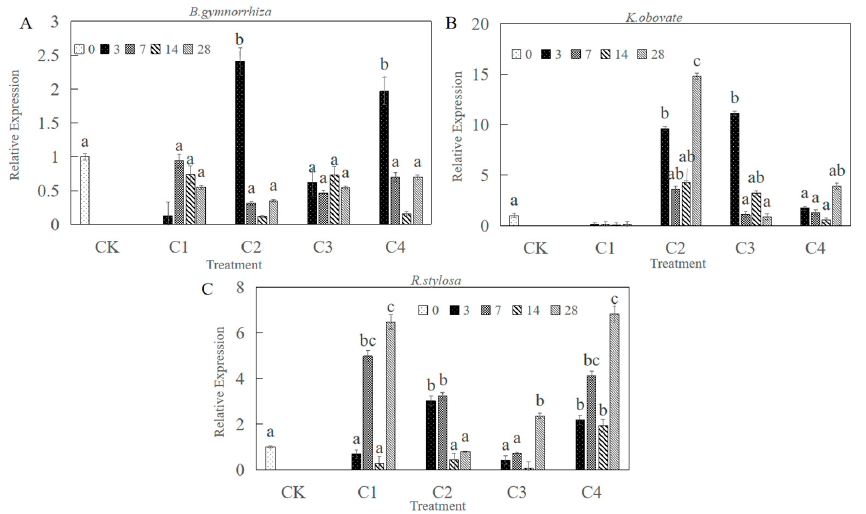
Figure 8. Expression of CHI gene in leaves of three species in response to heavy metal stresses using real-time quantitative PCR analysis. ( A ) Bruguiera gymnorrhiza. ( B ) Kandelia obovate. ( C ) Rhizophora stylosa . Data are the means ± standard of three separate individuals. Each bar with di ff erent lower- case le tt ers was signi fi cantly di ff erent ( p < 0.05).